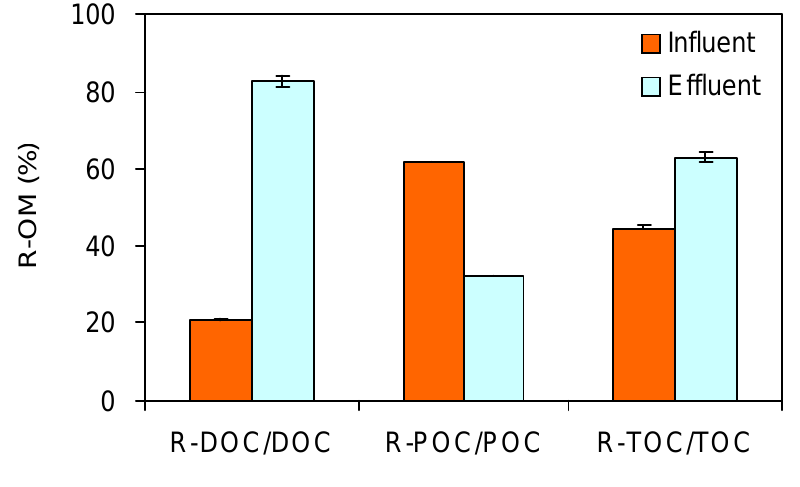
Figure 1. Percent distributions of R-OM for influent and effluent sewage from the wastewater treatment